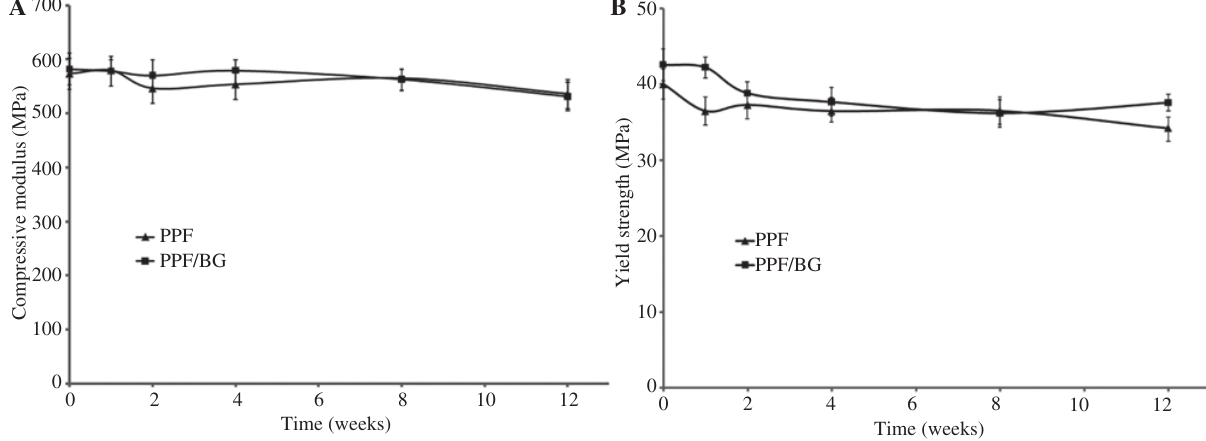
Figure 10 (A) Compressive modulus and (B) yield strength of PPF and PPF/BG scaffolds over the 12-week degradation